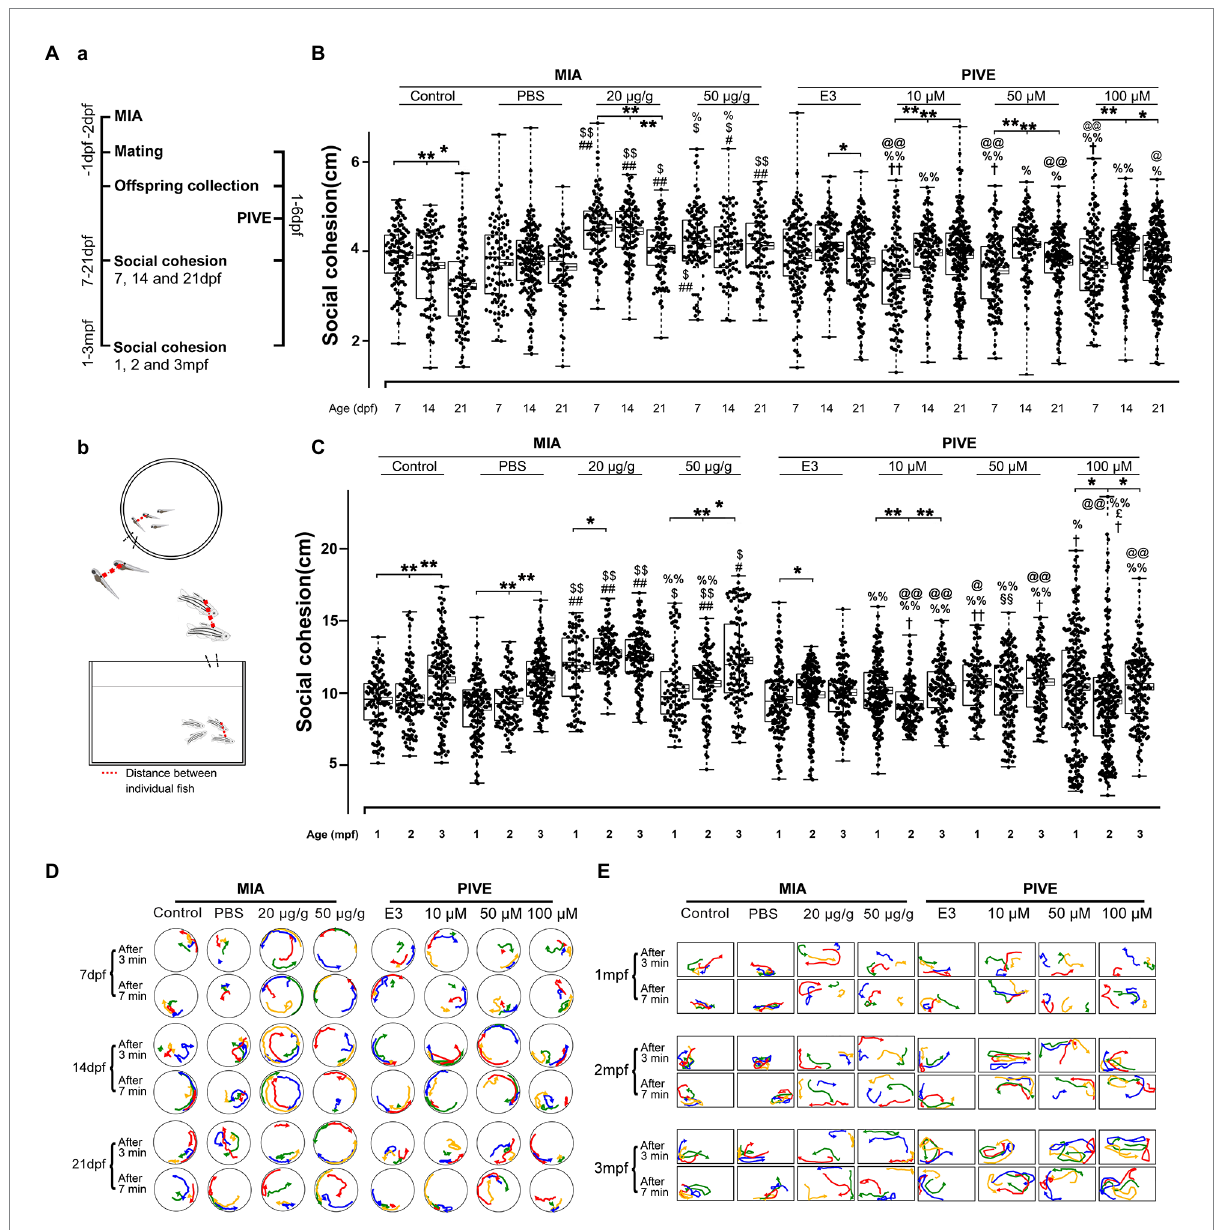
FIGURE 3 MIA offspring exhibited decreased social cohesion. (Aa) Zebrafish were tested for social cohesion (distance between individual fish) at 7, 14, and 21 dpf, and 1, 2, and 3 mpf (Ab) after maternal poly(I:C) injection (MIA) or PIVE to fertilized embryos. (B) Both MIA-20 and 50 μ g/g induced a decreased social cohesion at 7, 14, and 21 dpf (MIA-20 μ g/g: Z = 5.66, 6.31, and 5.57, p all <0.01 for 7, 14, and 21 dpf vs. MIA-Control; Z = 6.66, 7.45, and 3.59, p < 0.01, 0.01, and 0.05, respectively, for 7, 14, and 21 dpf vs. MIA-PBS. MIA-50 μ g/g: Z = 2.54, 2.68 and 5.95, p = 0.07, <0.05 and 0.01, respectively, for 7, 14, and 21 dpf vs. MIA-Control; Z = 3.69, 3.30, and 4.01, p < 0.05, 0.05, and 0.01, respectively, for 7, 14, and 21 dpf vs. MIA-PBS) but not for PIVE fish. (C) Both MIA-20 and 50 μ g/g induced a decreased social cohesion at 1, 2, and 3 mpf (MIA-20 μ g/g: Z = 5.76, 10.93, and 7.72, p all <0.01 for 1, 2, and 3 mpf vs. MIA-Control; Z = Z = 7.46, 11.63, and 5.77, p all <0.01 for 1, 2 and 3 mpf vs. MIA-PBS. MIA-50 μ g/g: Z = 1.60, 4.06 and 3.48, p > 0.05, <0.01 and 0.05, respectively, for 1, 2, and 3 mpf vs. MIA-Control; Z = 3.15, 4.85, and 3.51, p < 0.05, 0.01, and 0.05, respectively, for 7, 14, and 21 dpf vs. MIA- PBS), but not for PIVE fish. (D,E) Tracking of individual fish in a group of four fish shows impaired social cohesion in MIA fish. The movement of each group of fish was analyzed after video tracking. The positions of individual fish in 3 s periods at two different time windows (3 and 7 min, respectively) were traced, and their paths were presented in different colors (#1 fish in red, #2 fish in yellow, and so on). Aggregation of MIA- control/PBS and PIVE-E3 fish groups in a corner of tank is apparent, in comparison with MIA fish. Data are presented as mean ± SEM (right side of the histogram), median ± 75% confidence interval (left side of the histogram), and maximum and minimum. * p < 0.05, ** p < 0.001; # p < 0.05, ## p < 0.001 compared with the MIA-control group of the same age with social stimulus; $ p < 0.05, $$ p < 0.001 compared with the MIA-PBS group of the same age with social stimulus; % p < 0.05 ， %% p < 0.001 compared with the MIA-20 μ g/g group of the same age; @ p < 0.05 ， @@ p < 0.001 compared with the MIA-50 μ g/g group of the same age. † p < 0.05, †† p < 0.001 compared with the PIVE-E3 group of the same age with social stimulus. §§ p < 0.001 compared with the PIVE-10 μ M group of the same age; £ p < 0.05 compared with the PIVE-50 μ M group of the same age. Detail about the n and descriptive data for each group and statistical analysis results could be found in Additional file 11: File